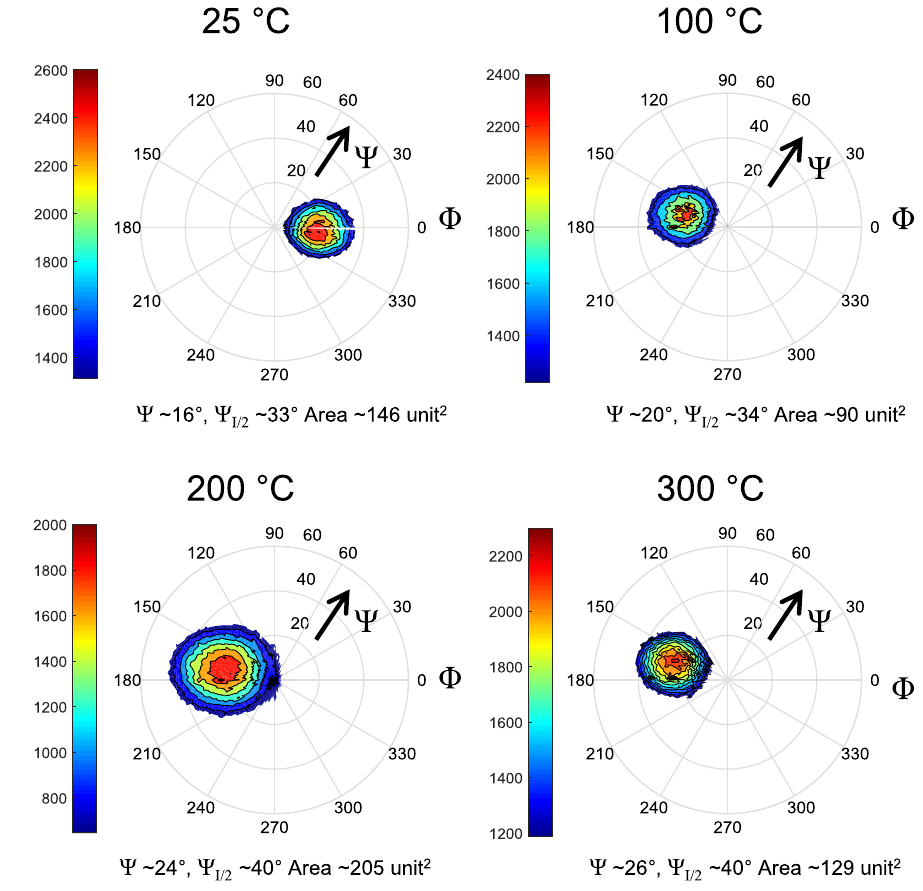
Figure 4. X-ray pole figures of ZnO grown on Al deposited at different T S , showing distribution of c -axis inclination angles with respect to the surface normal ( Ψ = 0). The calculated areas enclosed within the contour surrounding the maximum intensity indicate the dispersion of the c -axis inclination angles. Narrower dispersions (smaller area) are observed when ZnO is deposited on Al sputtered at T S = 100 °C. Large dispersions are observed in the case of Al sputtered at T S of 200 °C and 300 °C. A gradual increase of the mean value of Ψ (position of center of red regions) and the FWHM ( Ψ I/2 ) of the peak intensity can be observed as T S increases from 25 °C to 300